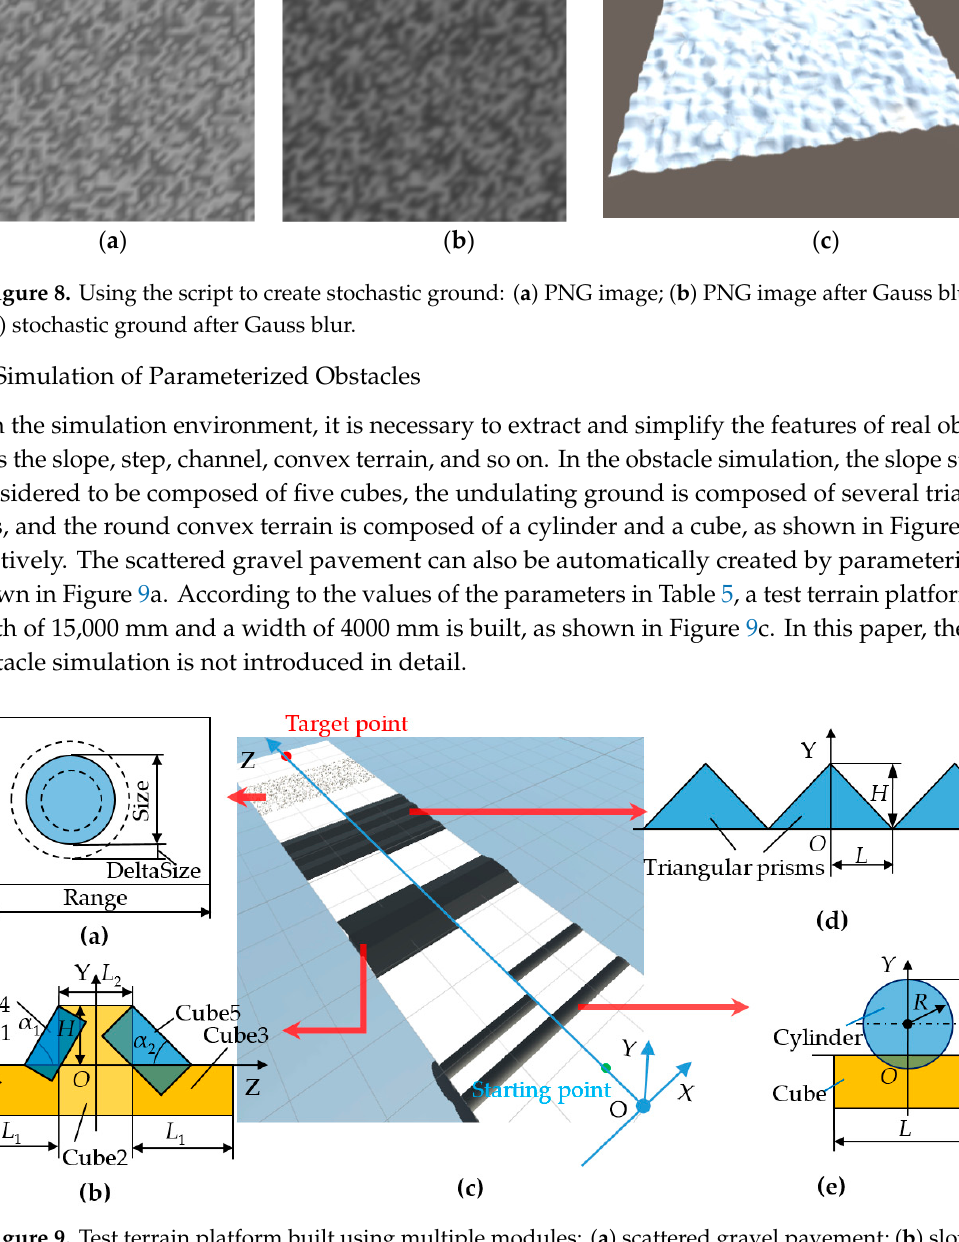
Figure 9. Test terrain platform built using multiple modules: ( a ) scattered gravel pavement; ( b ) slope step; ( c ) test terrain platform; ( d ) undulating ground; ( e ) round convex obstacle.